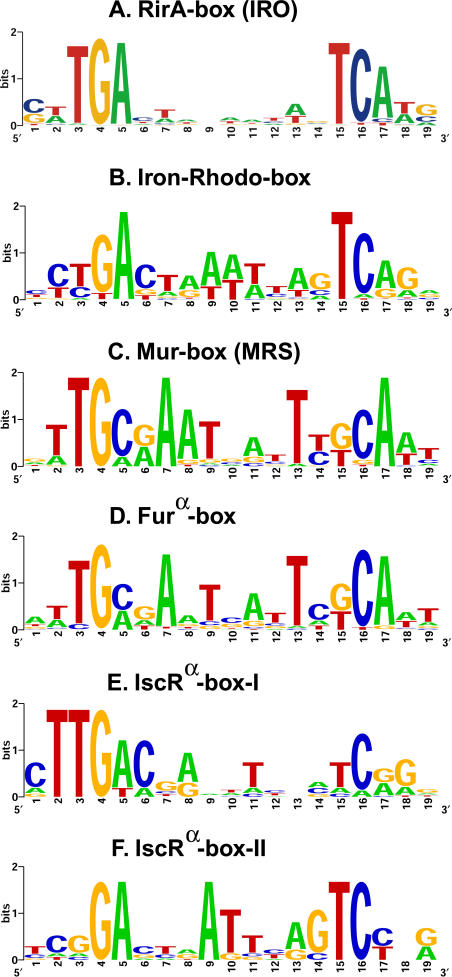
Sequence Logos for the Predicted Regulatory Sites in α-Proteobacteria(A) RirA-box (IRO) in eight species from the Rhizobiales order (four Rhizobiaceae, two Mesorhizobium species, Brucella, and Bartonella).(B) Iron-Rhodo-box in the Rhodobacteraceae.(C) Mur-box (MRS) in the Rhodobacteraceae/Rhizobiales.(D) Furα-box in other α-proteobacteria species.(E) IscRα-I motif in the Rhodobacterales, the Rickettsia, Pelagibacter, Oceanicaulis, Caulobacter, Parvularcula, Rhodospirillum, and Magnetospirillum species.(F) IscRα-II motif in the Sphingomonadales and Gluconobacter species.